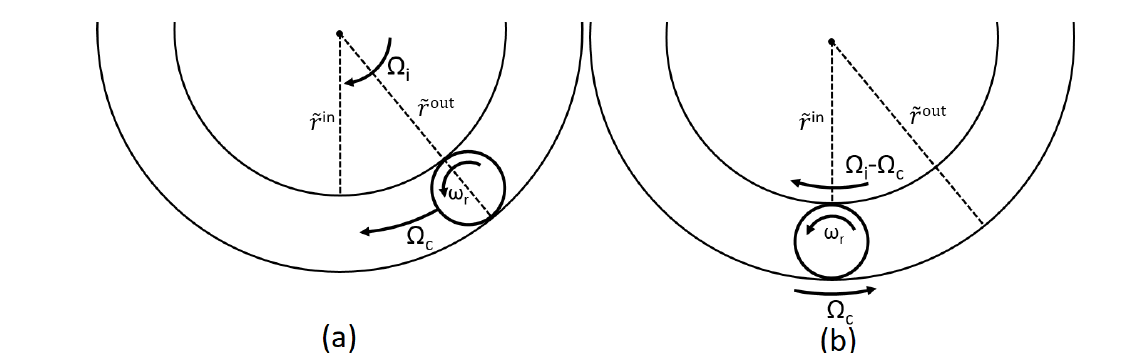
Figure B1. Roller orbiting bearing centre with respect to (a) stationary and (b) rotating reference frames; in the latter case the position of the roller centre remains fixed. (cid:127) i and (cid:127) c describe angular velocity with respect to the bearing centre, and ω r describes angular velocity with respect to the roller centre. Note the axis around which ω r is defined is tilted by the contact angle, α , relative to the (cid:127) i and (cid:127) c